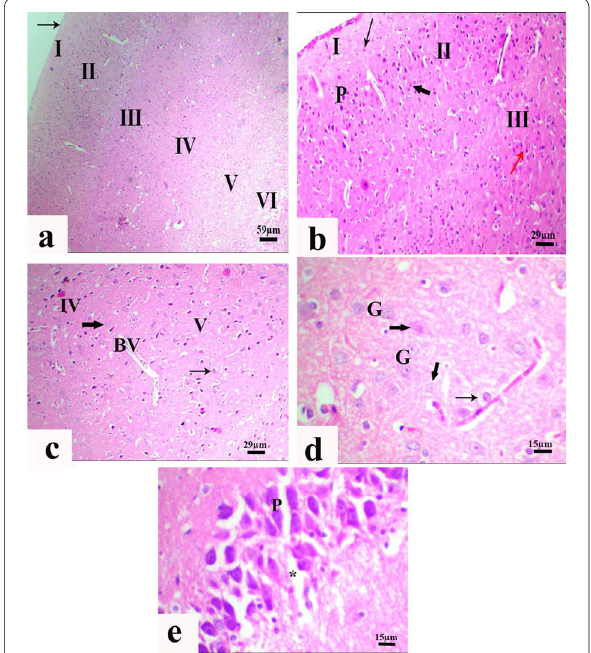
Fig.5 photomicrographs of sections of the cerebral cortex obtained from rats treated with paroxetine and ALA showing a : normal structure of the cerebral cortex; pia matter (arrow), molecular layer (I), outer granular layer (II), outer pyramidal layer (III), inner granular layer (IV), inner pyramidal layer (V) and the multiform layer (VI). b : molecular layer (I) contains neuroglial cells (thin arrow), external granular layer (II) with normal granule cells (thick arrow) and small pyramidal cells (P), and external pyramidal layer (III) had normal neurons (red arrow). c : showing internal granular layer (IV) with normal granule cell (thick arrow), and internal pyramidal layer (V) contains pyramidal cells (thin arrow) and blood vessel (BV). d : granule cells with open face nuclei and prominent nucleoli (G), while others appears as ghosts of nerve cells that lost their nucleoli and are faintly stained (thick arrows), and some vacuolated one (thin arrow). e : mostly normal internal pyramidal layer contained normal pyramidal cells (P), and neuropil (*) with few vacuoles